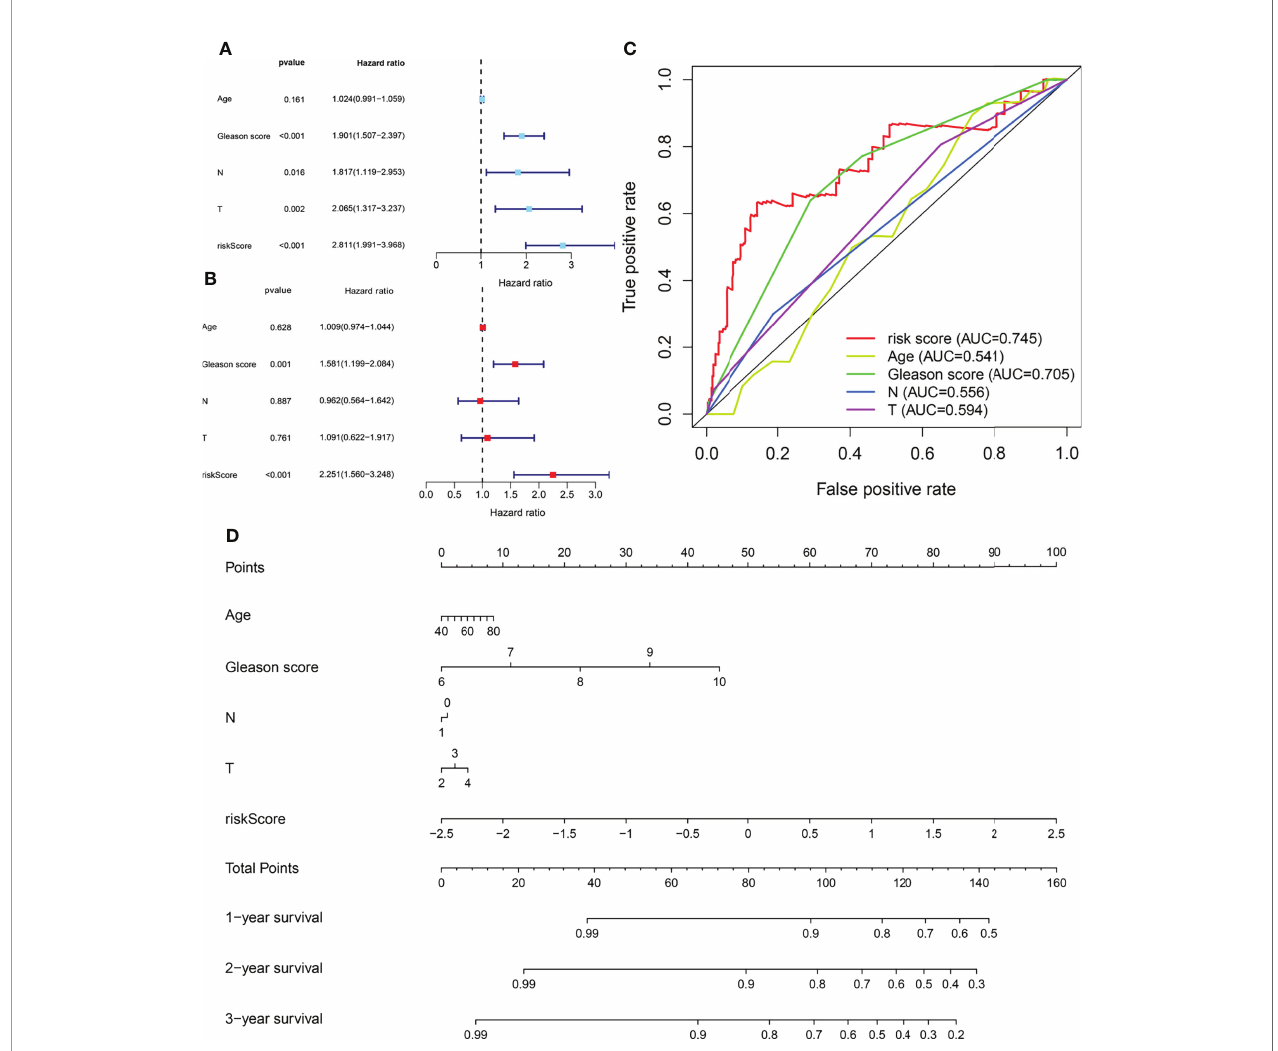
FIGURE 3 | Cox regression analysis, receiver operating characteristic (ROC) analysis, and nomogram of independent prognostic factors and metabolic prediction models (MPMs) in prostate adenocarcinoma (PRAD) patients. (A, B) Univariate and multivariate Cox regression analyses enrolling clinical pathologic parameters and MPMs are illustrated in The Cancer Genome Atlas (TCGA) cohort using forest plots. Risk score of MPMs signi fi cantly predict prognosis for PRAD patients in TCGA. (C) ROC analysis shows robust predictive value of MPMs in TCGA cohort (area under the curve (AUC) = 0.745). (D) A nomogram was constructed based on four independent prognostic factors in PRAD